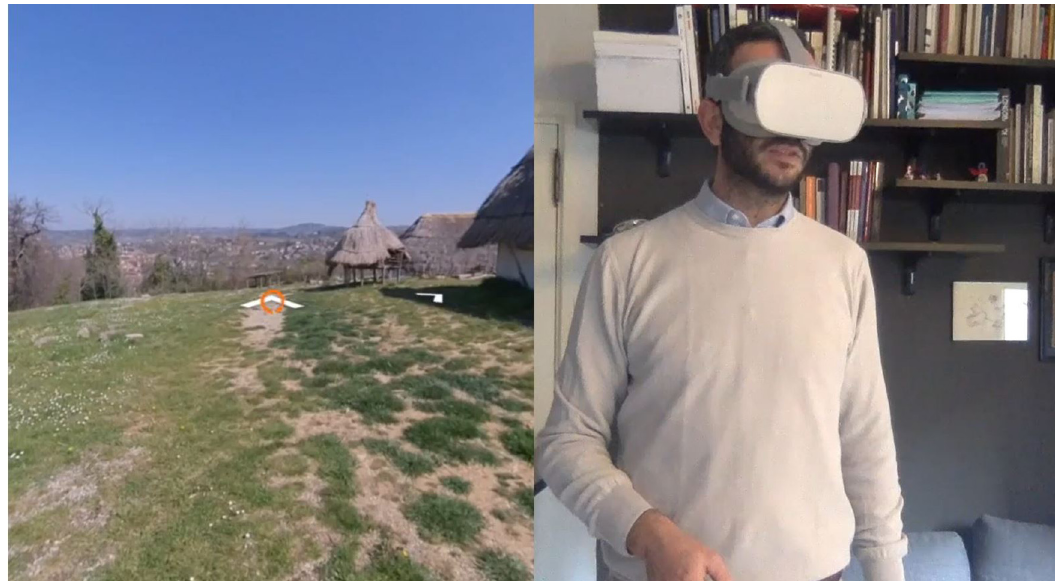
Figure 9: Virtual tour of the open - air museum of Poggibonsi.